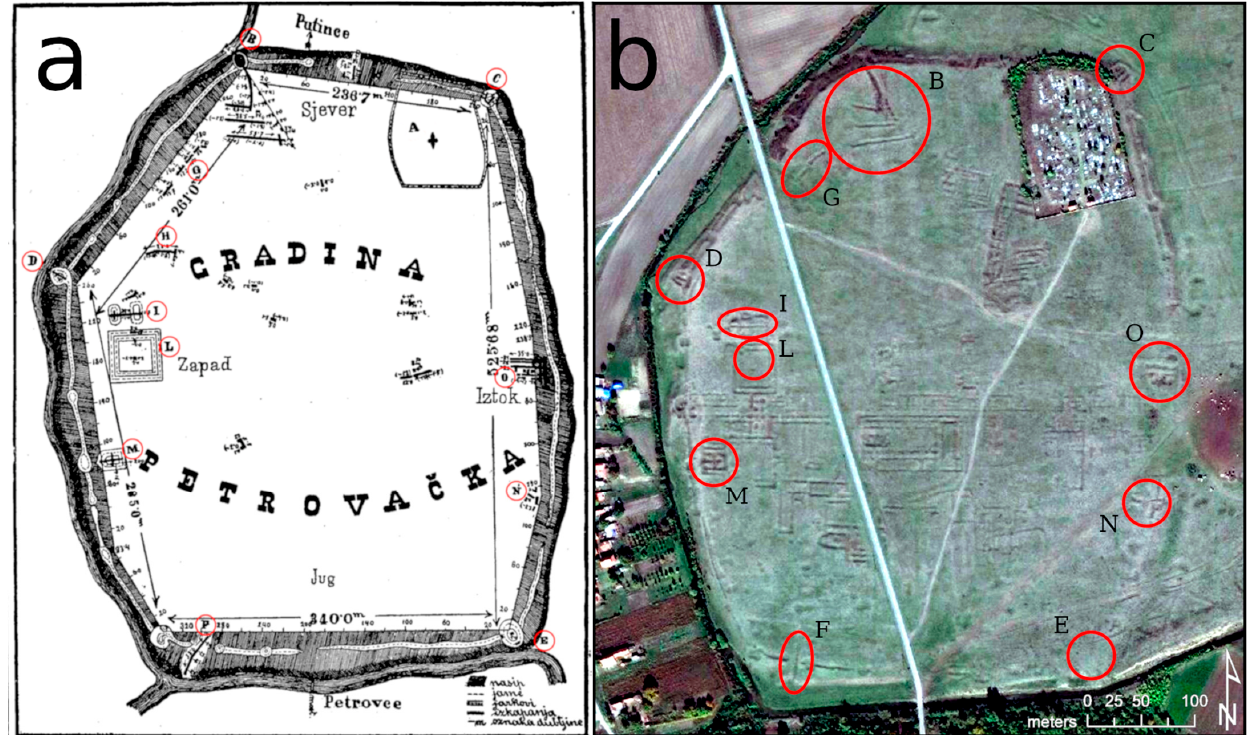
Figure 2. Plan from 1883, indicating Ljubi ć ´s excavation trenches ( a ) which are still visible in the present-day terrain ( b ). Plan: [5] p. 45. Image of b : Esri basemap by Esri, DigitalGlobe, GeoEye, i-cubed, USDA, USGS, AEX, Getmapping, Aerogrid, IGN, IGP, and the GIS User Community.